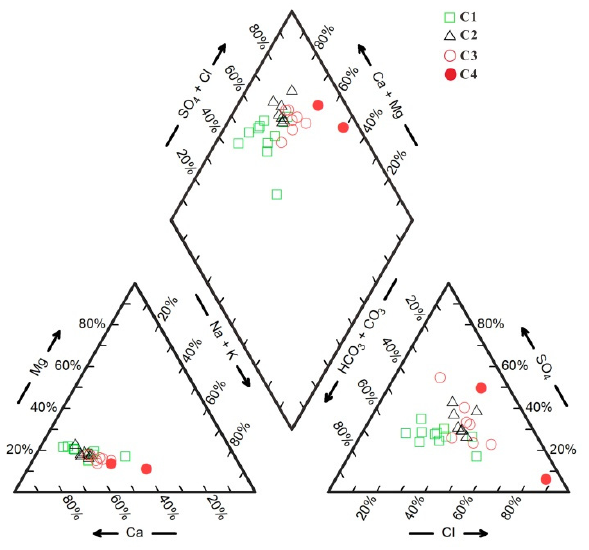
Figure 3. Piper three-line diagram of groundwater hydrochemistry in the study area.